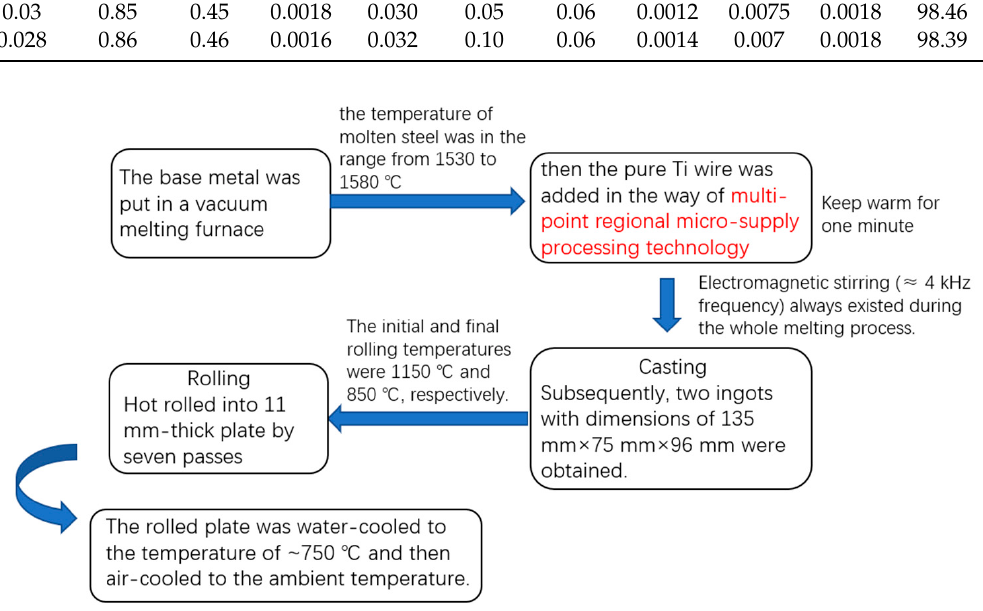
Figure 1. The preparation process of high strength naval steel. Table 1. Chemical compositions of the tested high strength naval steel (Wt %).